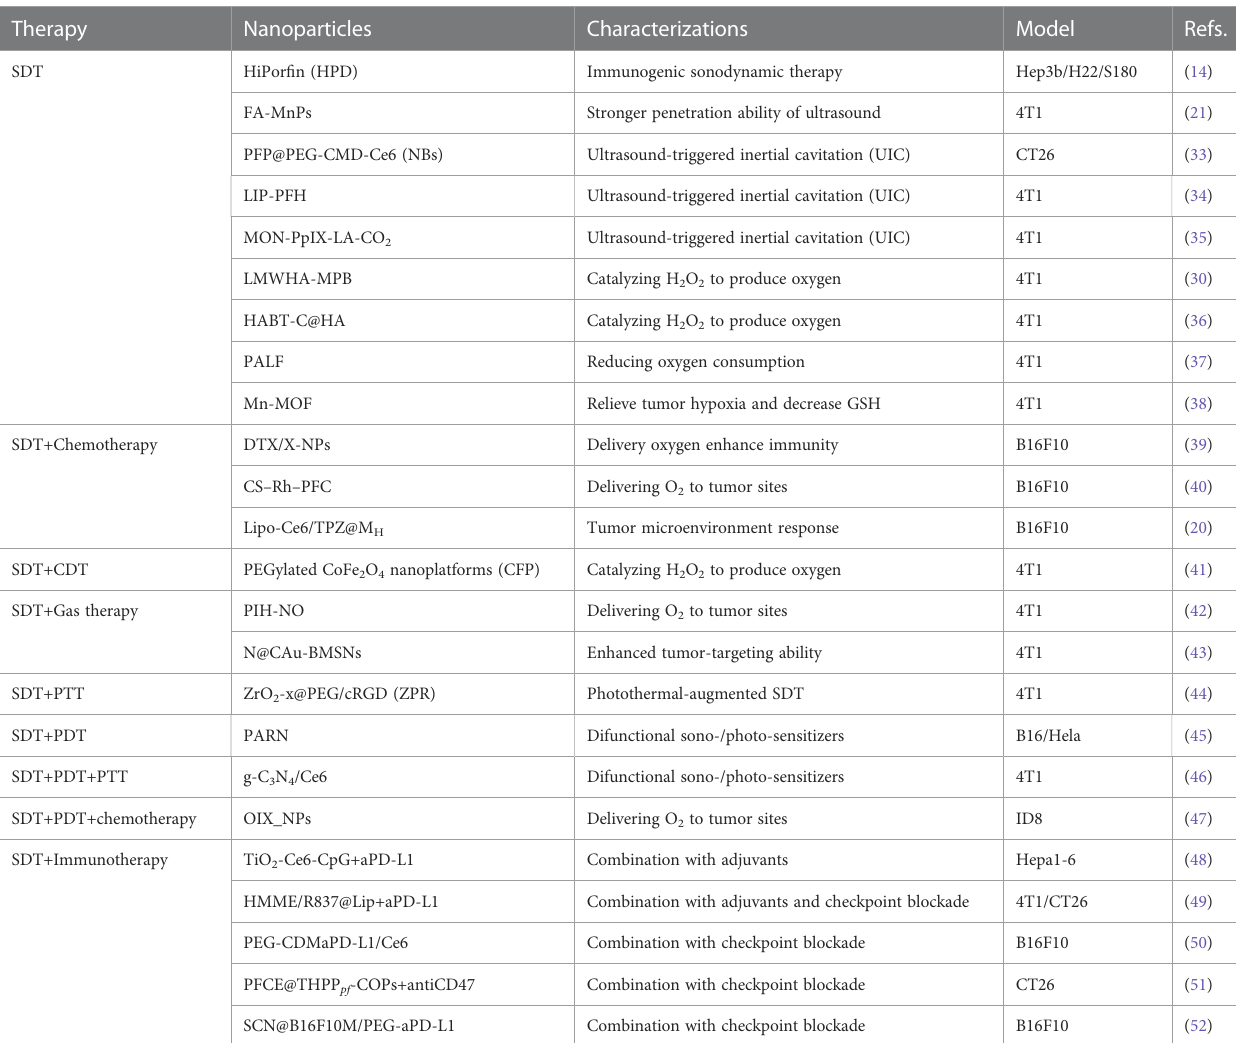
TABLE 1 Main strategy and characterizations of the sonodynamic therapy. Therapy Nanoparticles